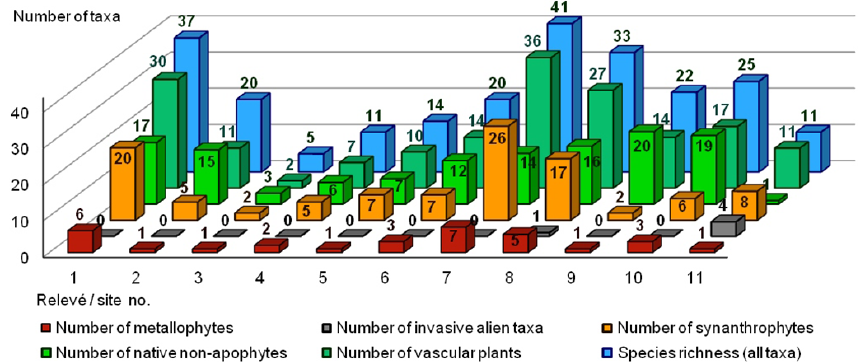
Figure 2. Numbers of the several types of determined taxa. The sites belong to these categories: wetland (site 1), initial successional stages (2–6), grasslands (7–8), forest stands (9–10), place for feeding wild animals (11). Table 2. Several diversity indexes of vegetation sampled in the individual phytocenological relevés and calculated separately for the total taxa determined in the sites, bryophytes and vascular plants. (PWA is a place for feeding wild animals). The mean indexes of sites divided into five habitats are presented in a table in the Supplement. Habitats Wetland Initial successional stages Grasslands Forest stands